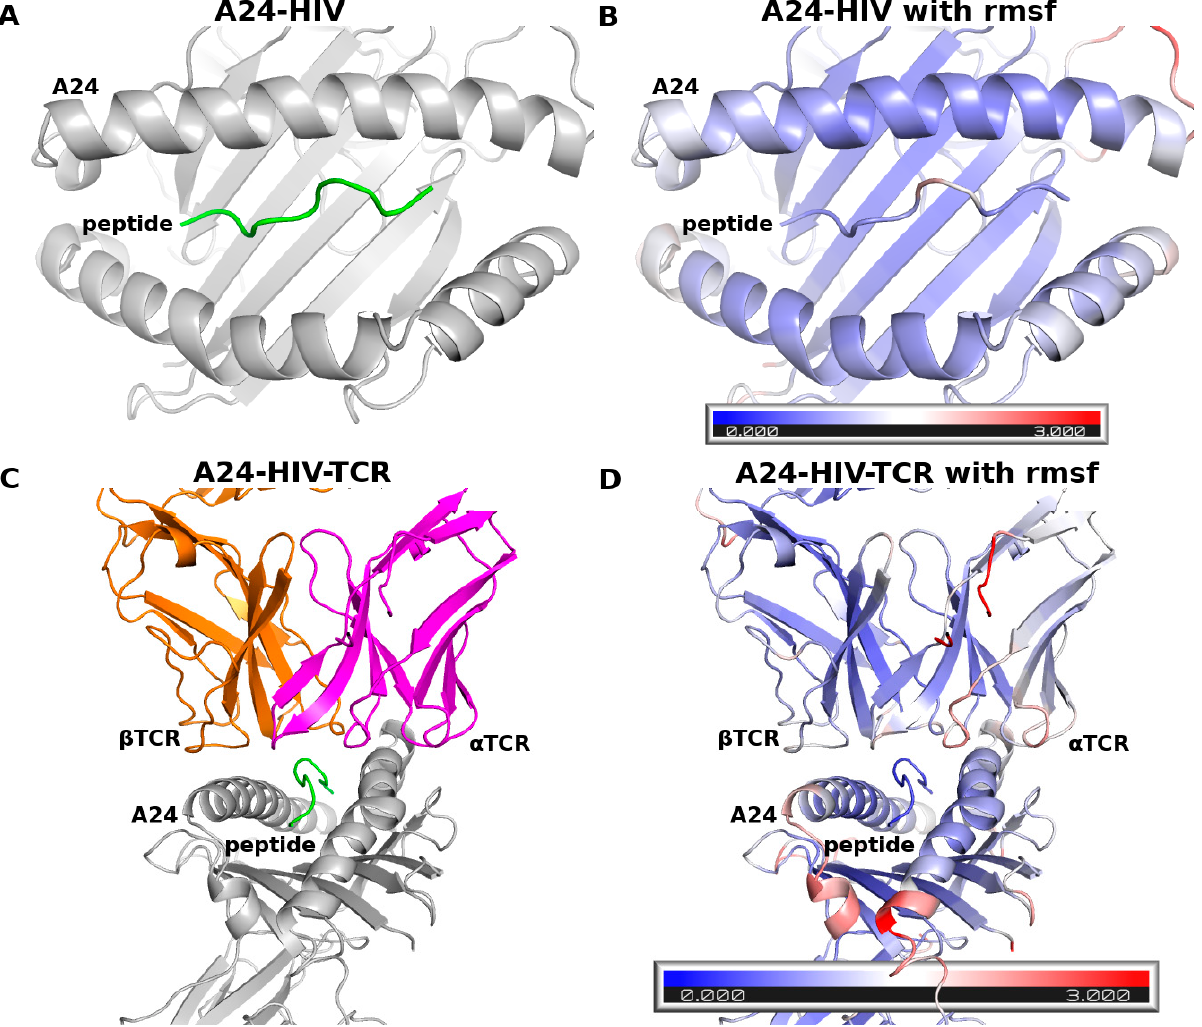
Figure 2. C α RMSF during the last 200 ns of the MD simulations mapped onto the structures of ( A , B ) A24-HIV and ( C , D ) A24-HIV-TCR complexes; the colors represent the fluctuations from very low (blue) to 3 Å